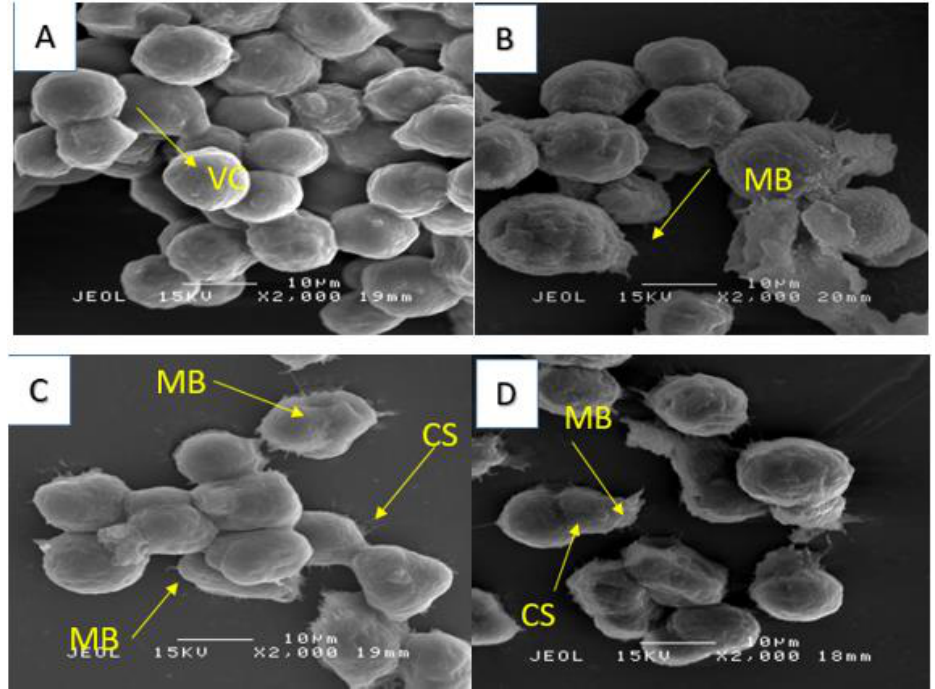
Figure 11. SEM micrograph for MCF-7 cell line. Untreated cells ( A ), treated cells 24 h ( B ), 48 h ( C ) and 72 h, respectively ( D ). (VC) viable cells; MB, membrane blebbing; CS, cytosolic shredding.